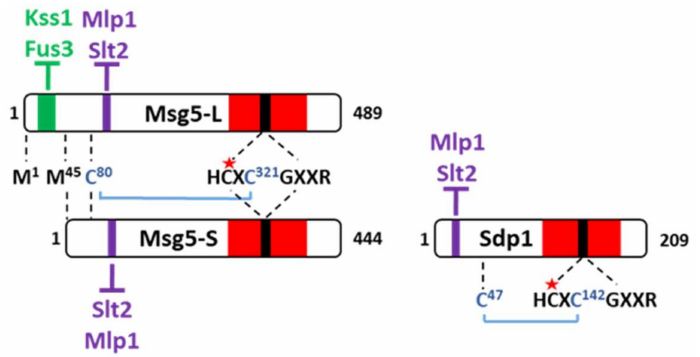
Figure 2. Diagram of the domain composition of S. cerevisiae MKPs Msg5, and Sdp1. Msg5-L corresponds to the long translational isoform of Msg5 and Msg5-S to the shorter one. The docking (D)-domain, IYT-motif, and phosphatase domain are drawn in green, purple, and red, respectively. The active site is represented in black and, inside this signature, the essential catalytic cysteine residue is labelled with a red star. The disulfide bond between the non-catalytic cysteine residue within the active site and its upstream cysteine partner is illustrated in blue. The target MAPKs are represented in green or purple, depending on the docking site involved in the